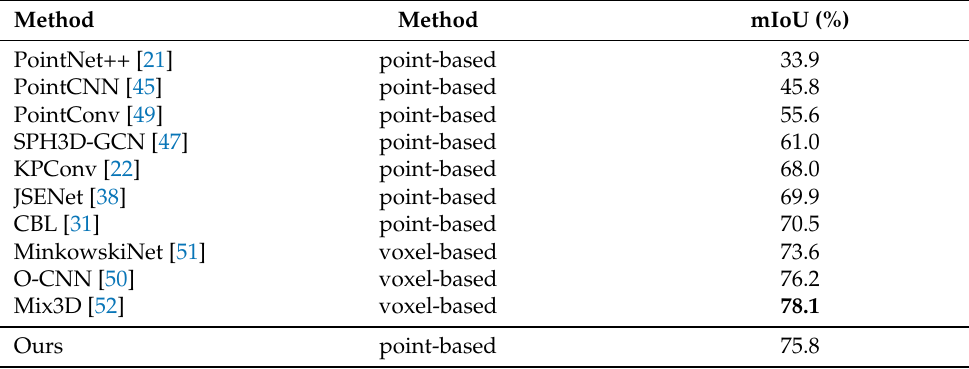
Table 2. Quantitative comparison with state-of-the-art methods on ScanNet v2 dataset. The bold denotes the best